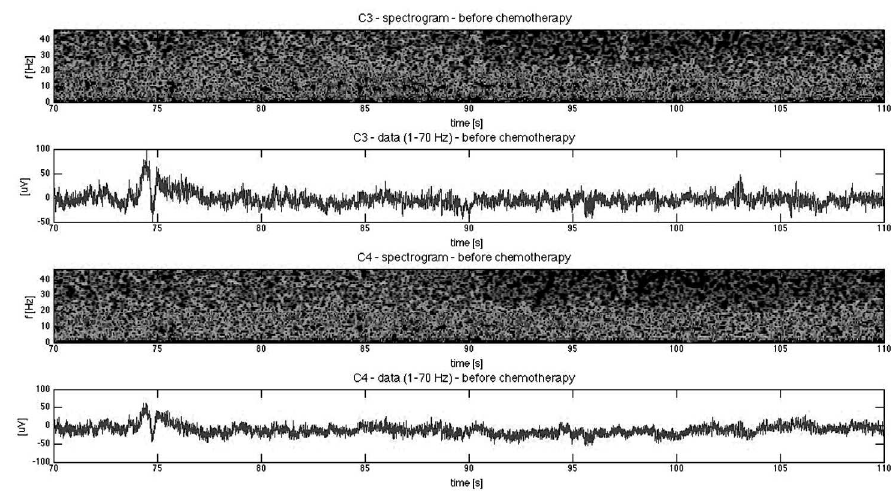
Figure 1. Spectrogram and EEG data from C3 and C4 electrodes, 40s of recording, eyes closed – before chemotherapy